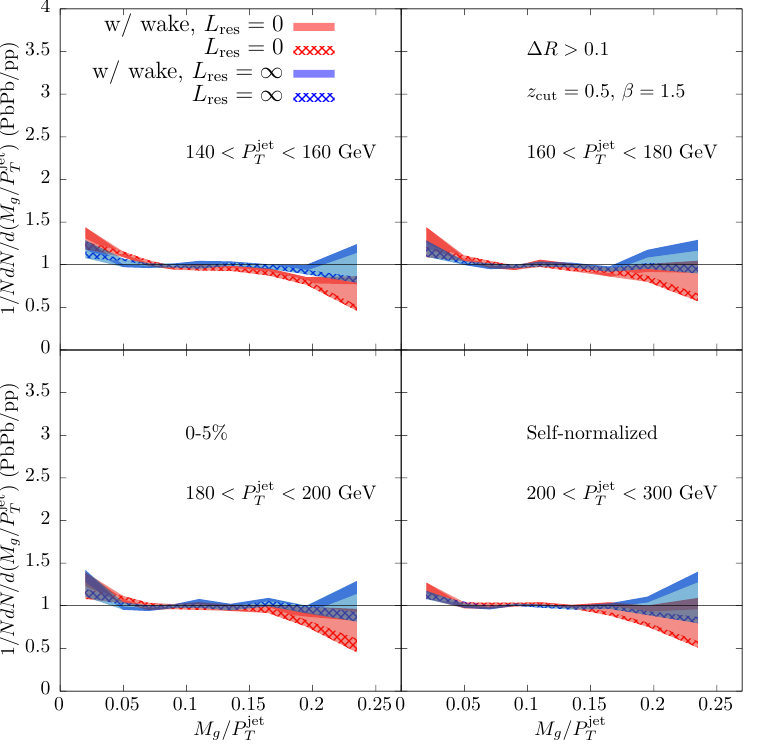
Figure 14 . Ratios of the individually self-normalized distributions of M g =p jet those in pp collisions, for di(cid:11)erent ranges of the un-groomed jet momentum p jet grooming procedure, with Soft Drop parameters z cut = 0 : 5 ; (cid:12) = 1 : 5. Red (blue) curves correspond to model calculations with a medium that has L res = 0 ( L res = 1 ). Solid curves correspond to the full results which include particles coming from the wake in the medium; in dashed curves we show results which don’t include